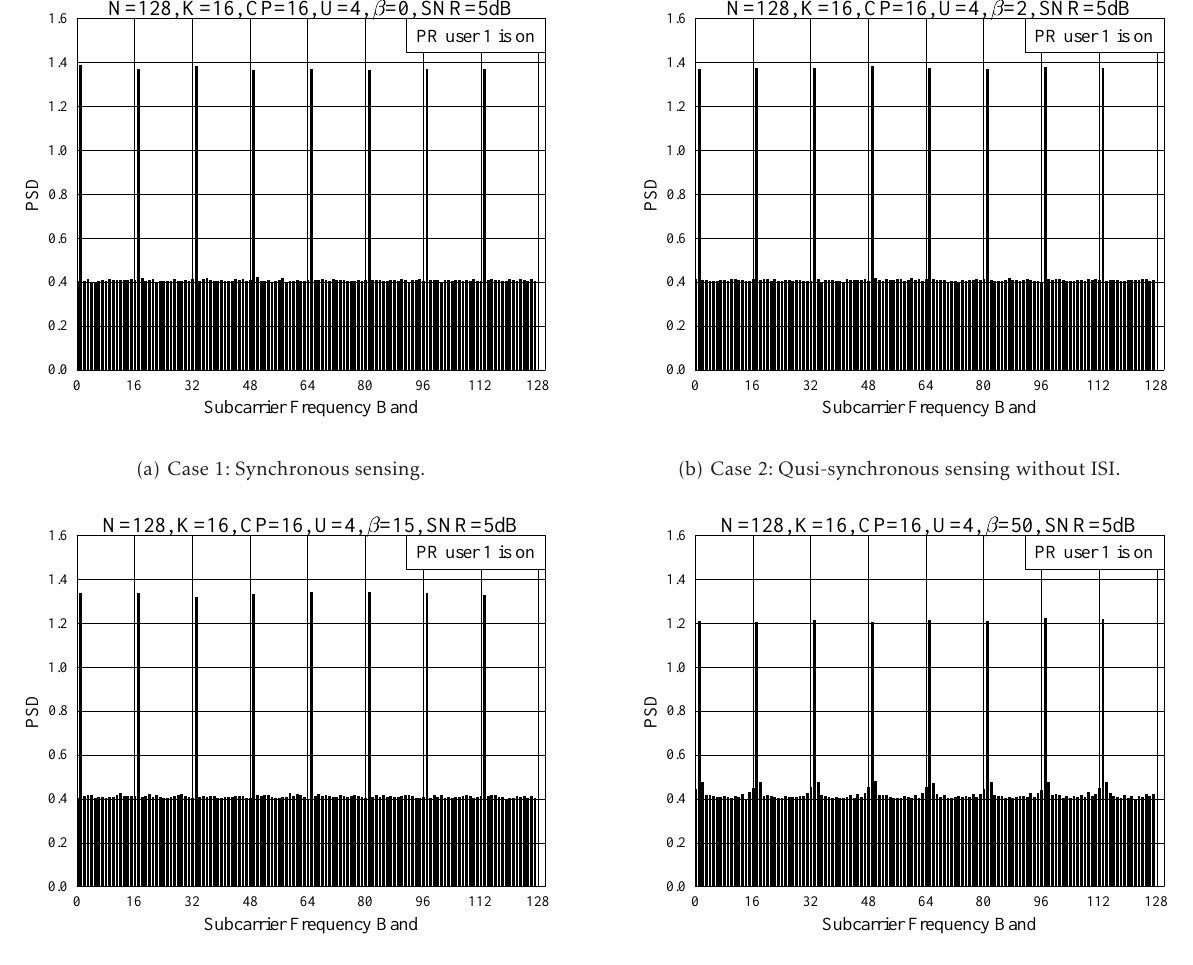
Figure 7. Power spectral density presenting at the CRSNs in an IFDMA system using 128 subcarriers to support maximum 16 users, when communicating over multipath Rayleigh fading channels having 5 time-domain resolvable paths. The results were obtained from 10000